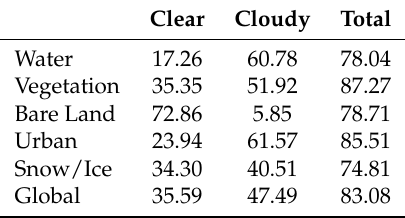
Table 13. Global Consensus of PCDA, CDA, ANN, KNN (last row) and separately on different surface types when different separate classifications are performed for each surface type.